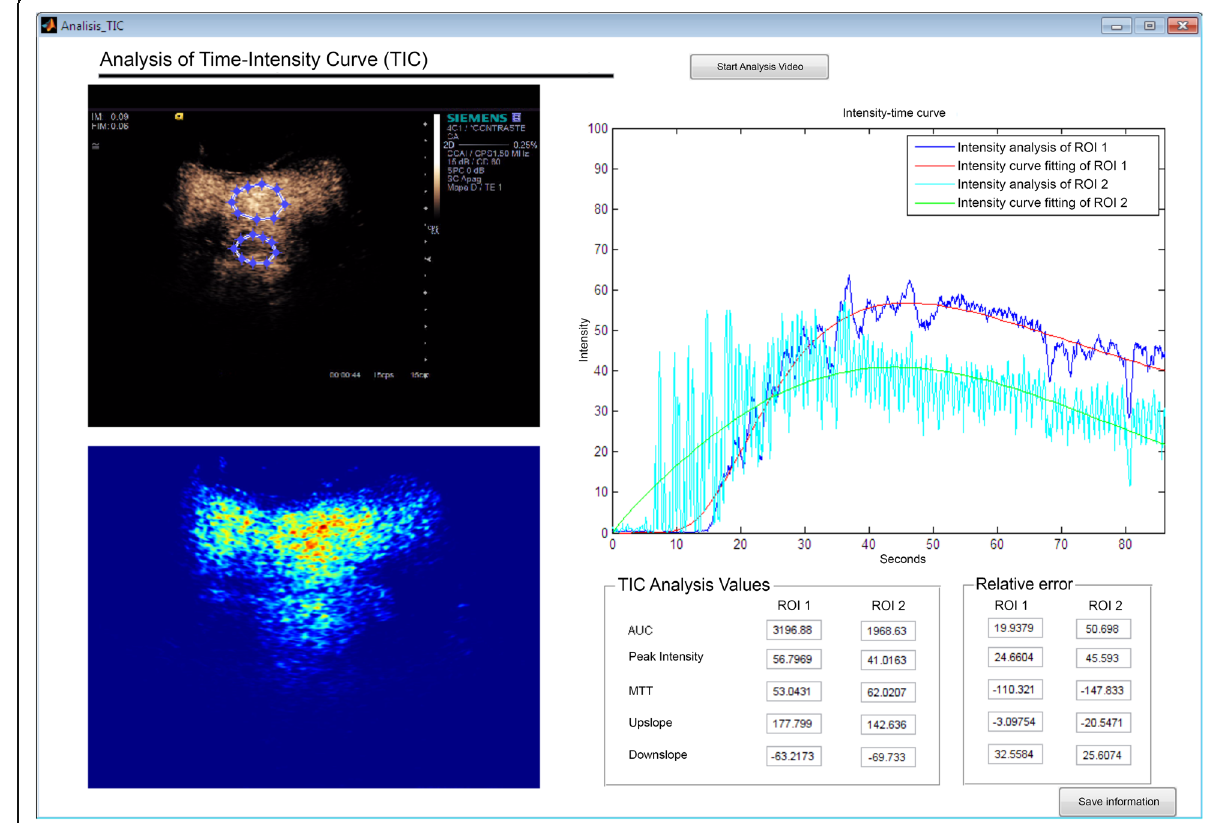
Fig. 4 User interface of the perfusion analysis tool. The user interface contains axes to visualise the time-intensity curve (TIC) and the results of the analysis in two different ROI. It also includes the possibility of visualising the ultrasound video for regions of interest delineation